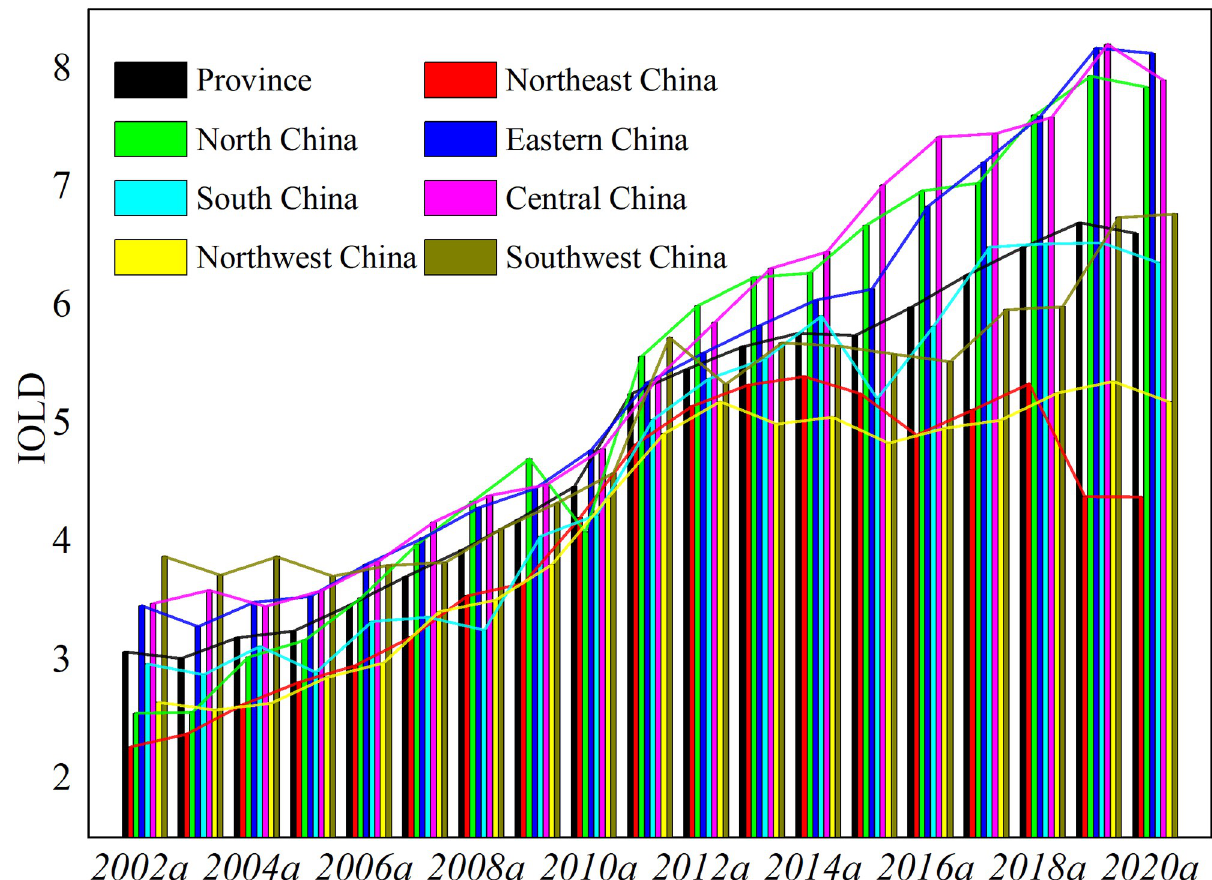
Fig 2. Mean change curve of land development intensity from 2002 to 2020.